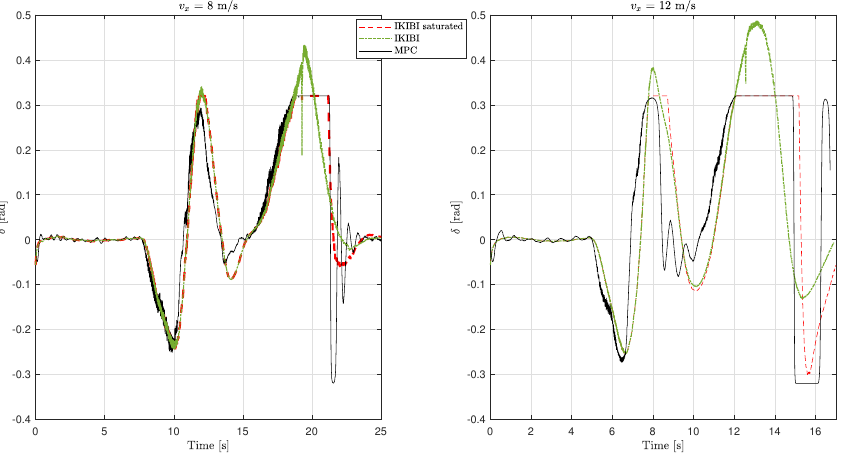
Figure 4. Front wheel steering temporal evolution: noiseless, fast sensor feedback test. ( left ) v x = 8 m/s and ( right ) v x = 12